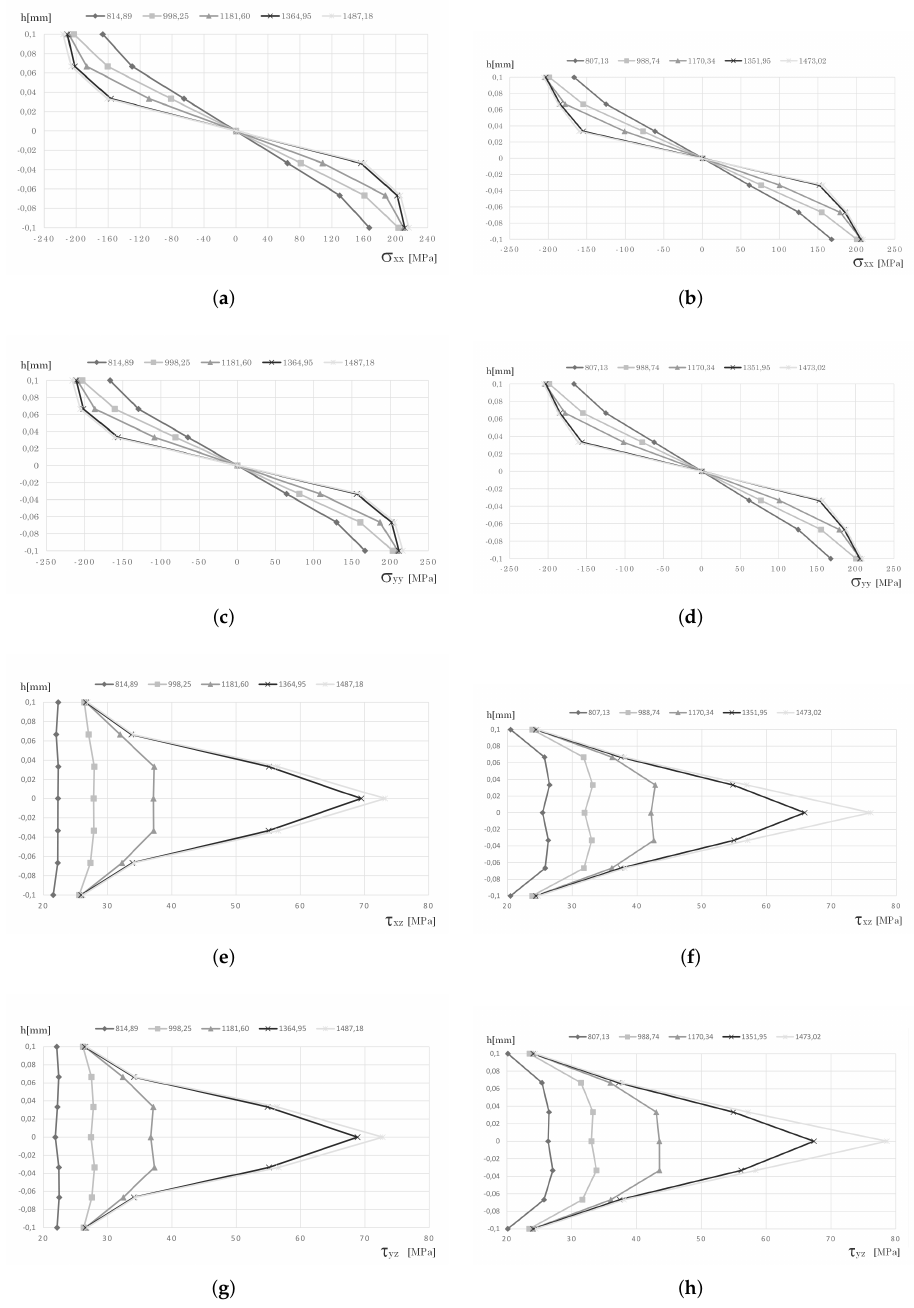
Figure 5. Stress distribution along the thickness in line A-A’ for the simply supported plate. FEM analysis ( a ) σ xx , ( c ) σ yy , ( e ) τ xz and ( g ) τ yz . RPIM analysis ( b ) σ xx , ( d ) σ yy , ( f ) τ xz and ( h ) τ yz . Load increments in [kN/m 2